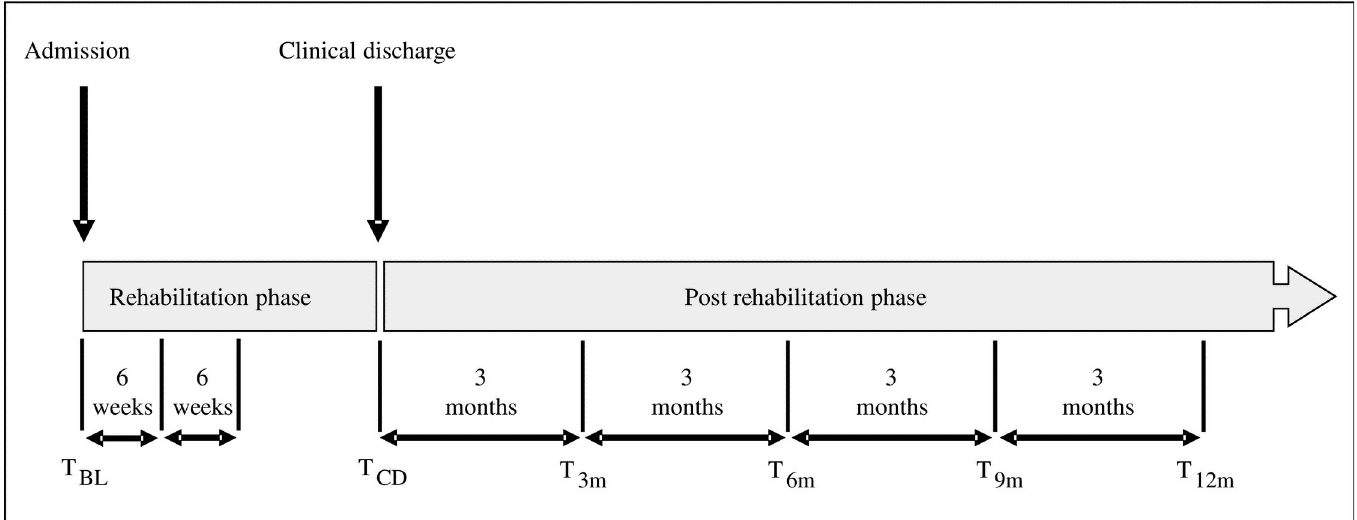
Fig 1. Overview of measurement timing. T = time; BL = baseline; CD = clinical discharge; M = month.